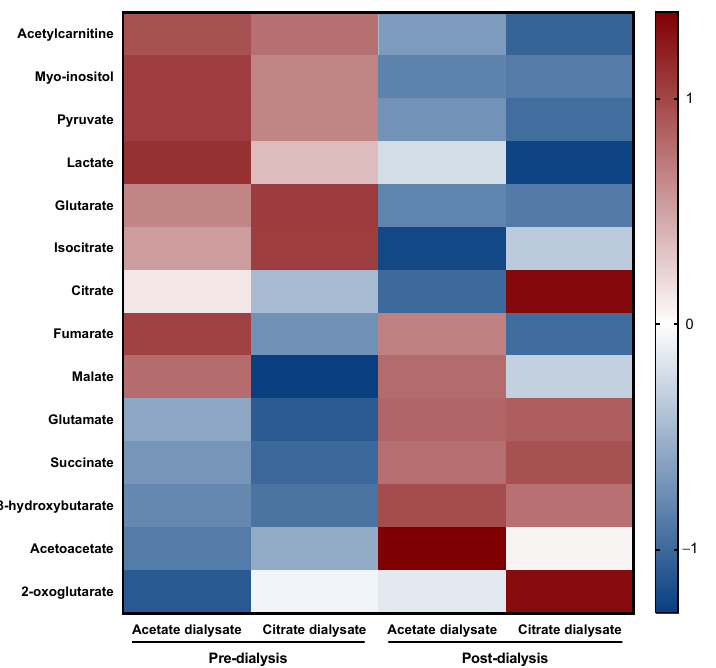
Figure 1. Heat map representing the normalized data by Z-scoring of each metabolite in the four measurement times. It is clear that dialysis per se has a catabolic effect and that most of the differences are produced by the treatment; however, it is visible that, in some cases, the metabolite concentrations are very disparate between dialysates.